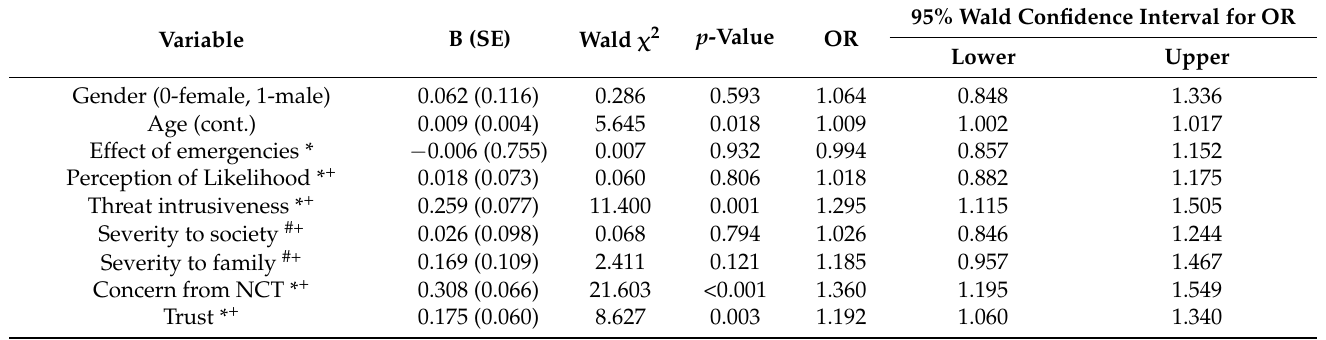
Table 6. Results of ordinal logistic regression analysis to predict behavioral intention to seek